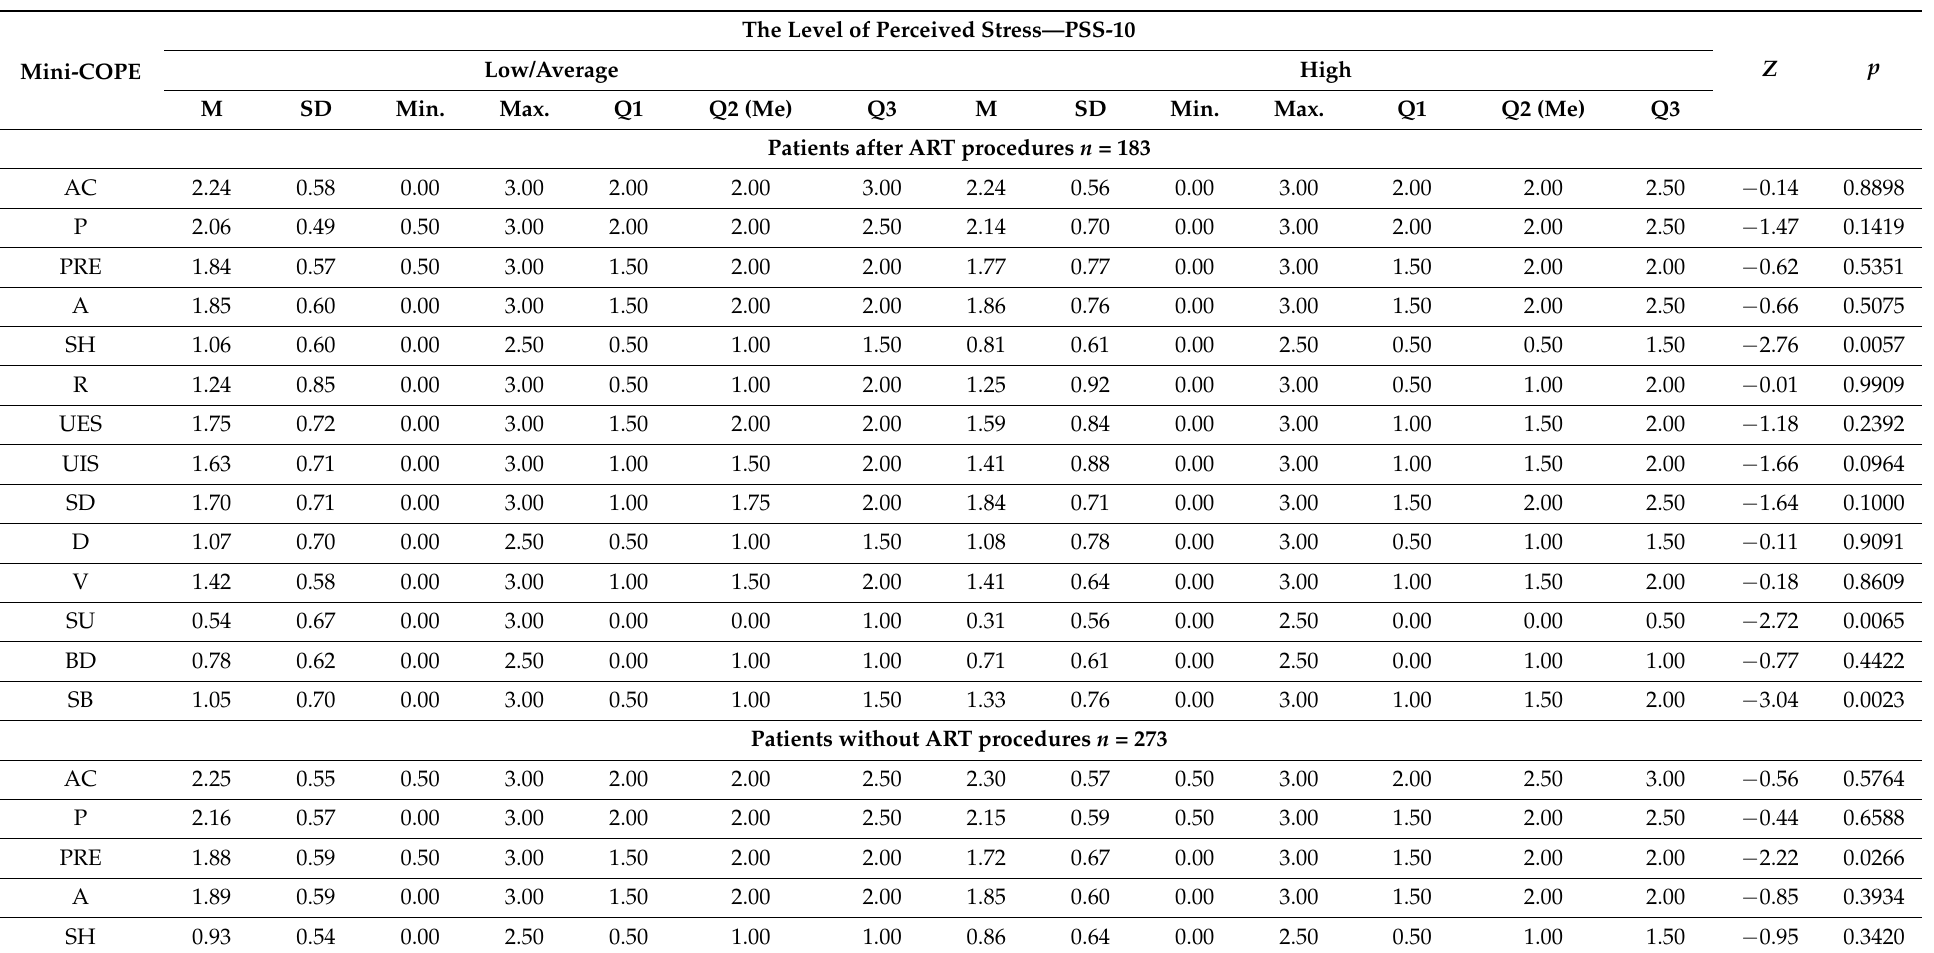
The Level of Perceived Stress—PSS-10